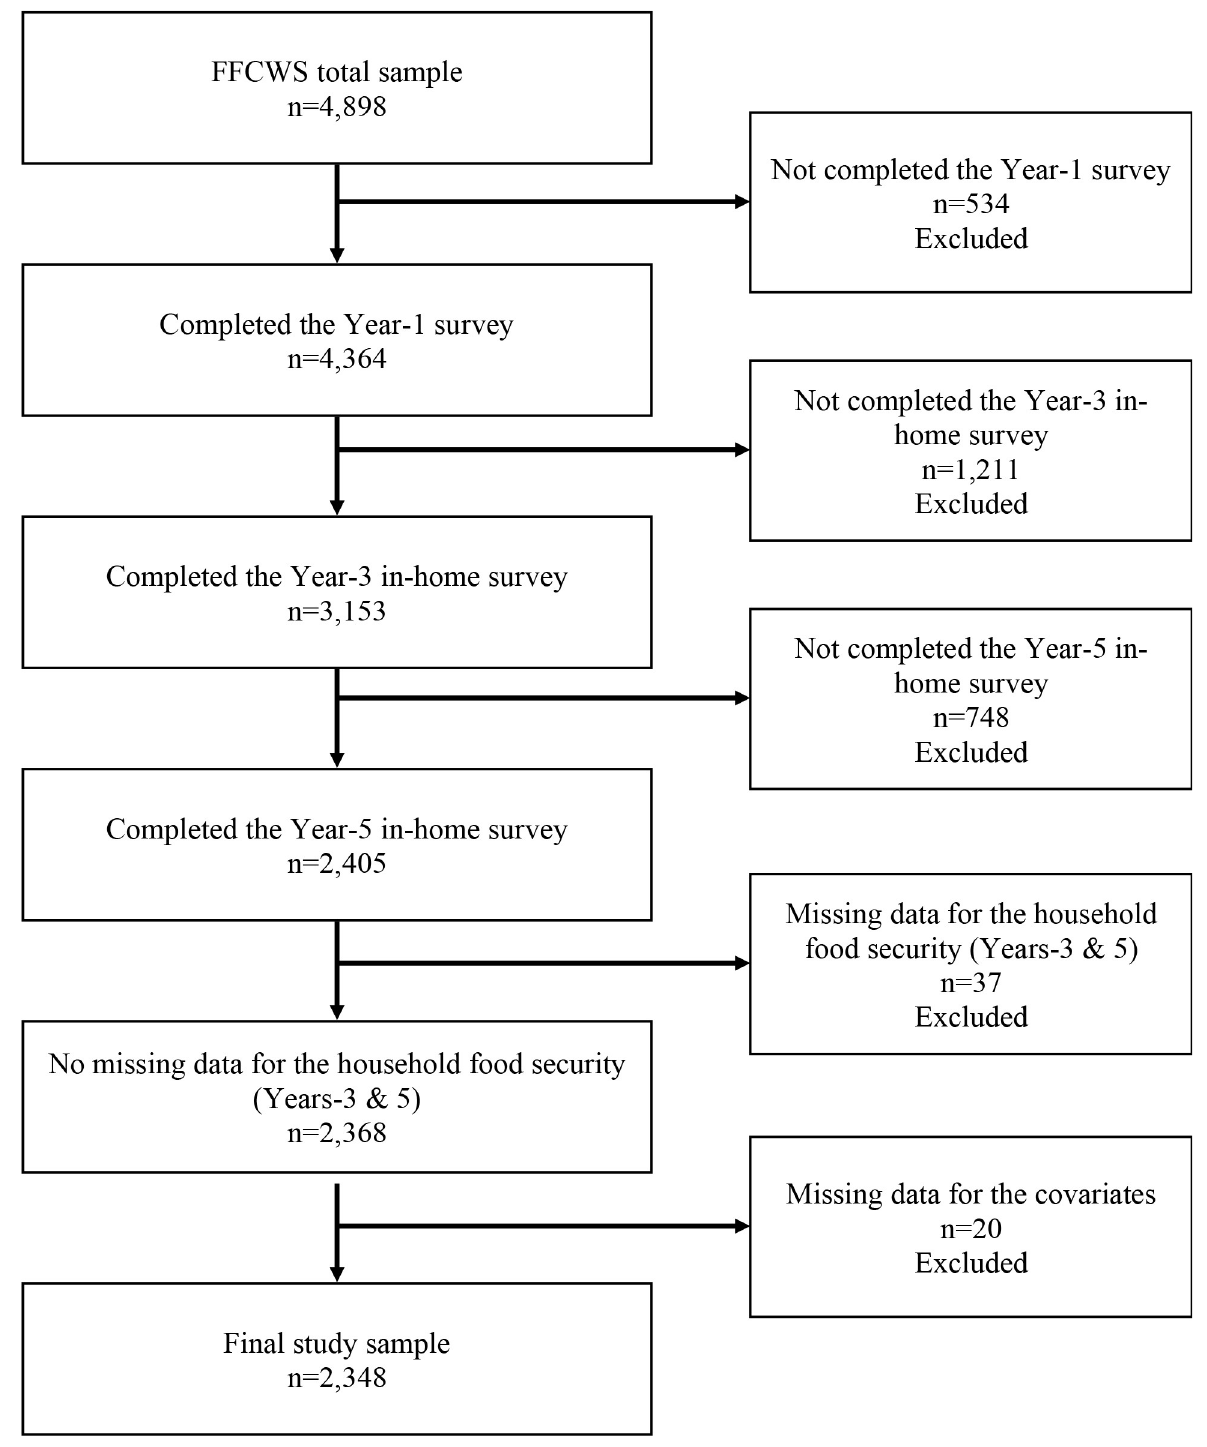
Fig 1. Sample selection for the current study from the overall FFCWS dataset.